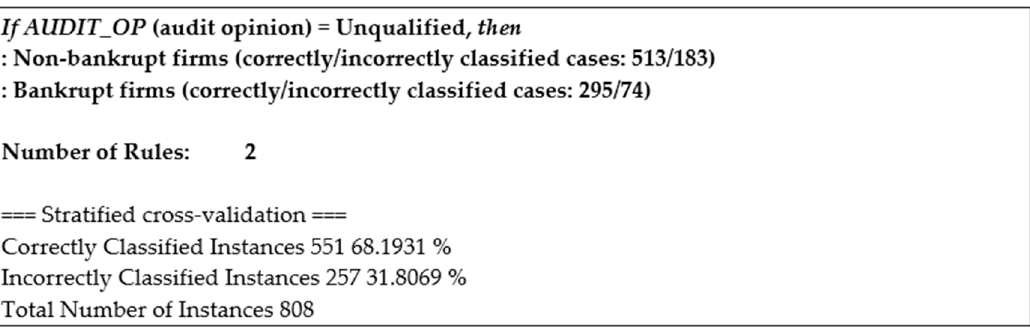
Figure 1. Model 1: The audit opinion PART model.